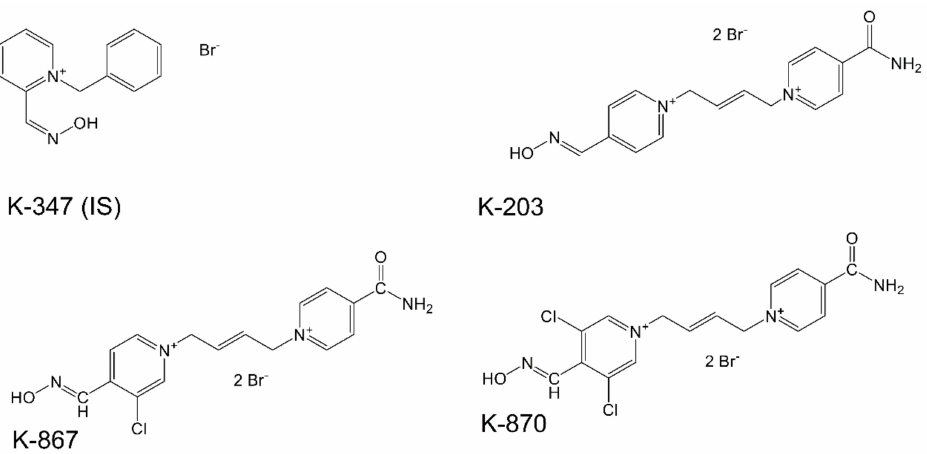
Figure 1. Chemical structures of K-347(IS), K-203, K-867 and